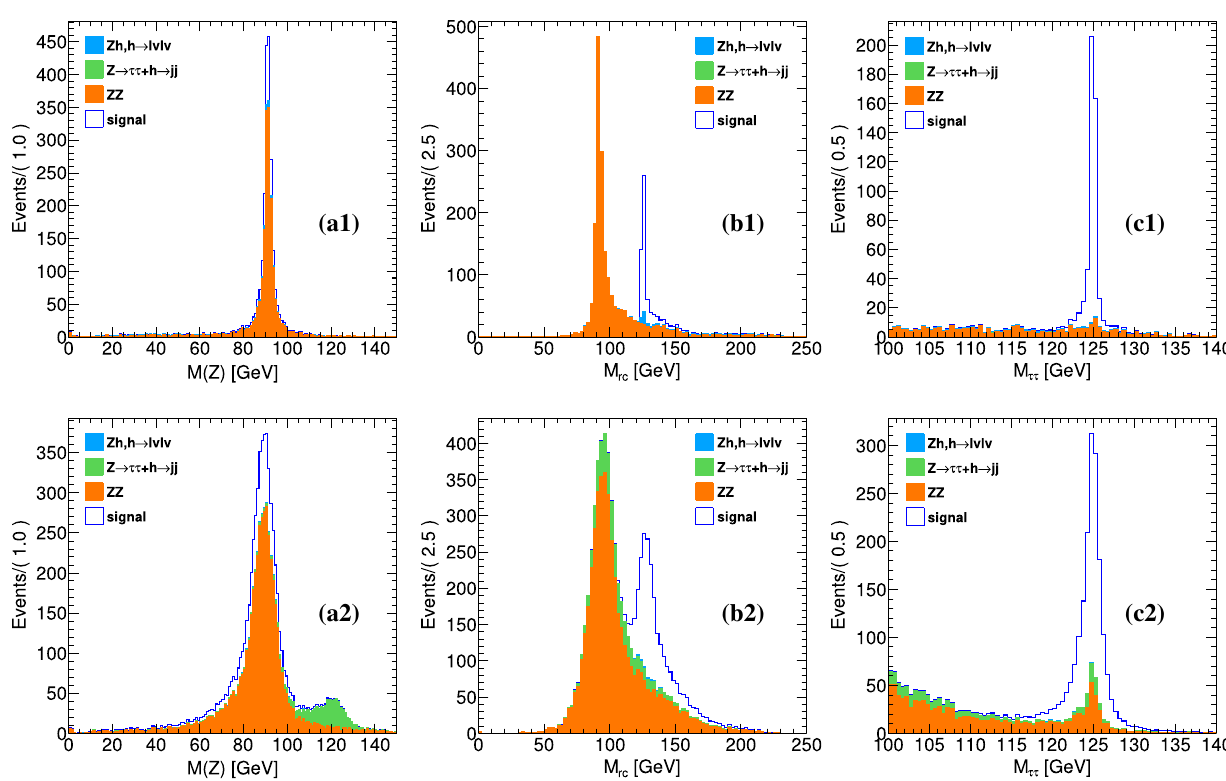
Fig. 5 The distributions of m Z ( a1 , a2 ), m RC ( b1 , b2 ) and m h ( c1 , c2 ) for the Z → (cid:3)(cid:3) ( a1 , b1 , c1 ) and Z → jj ( a2 , b2 , c2 ) decays with the three h tau decay modes considered and assuming 5 ab − 1 of data. Note that the (cid:3) + π/ρ and Z → jj channels are